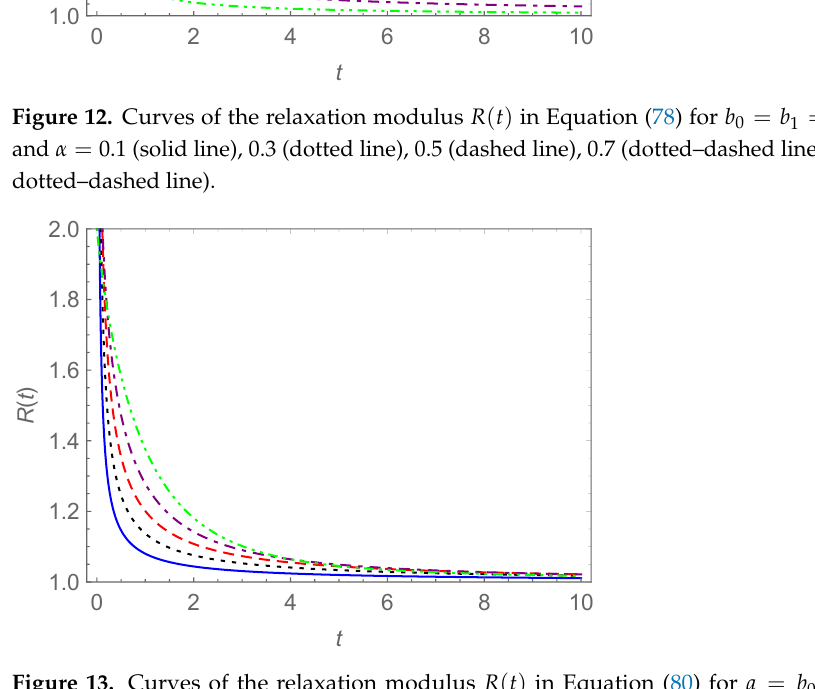
Figure 13. Curves of the relaxation modulus R ( t ) in Equation (80) for a = b 0 = b 1 = b 2 = 1, β = 0.9, and α = 0.1 (solid line), 0.3 (dotted line), 0.5 (dashed line), 0.7 (dotted–dashed line), and 0.9 (dotted–dotted–dashed